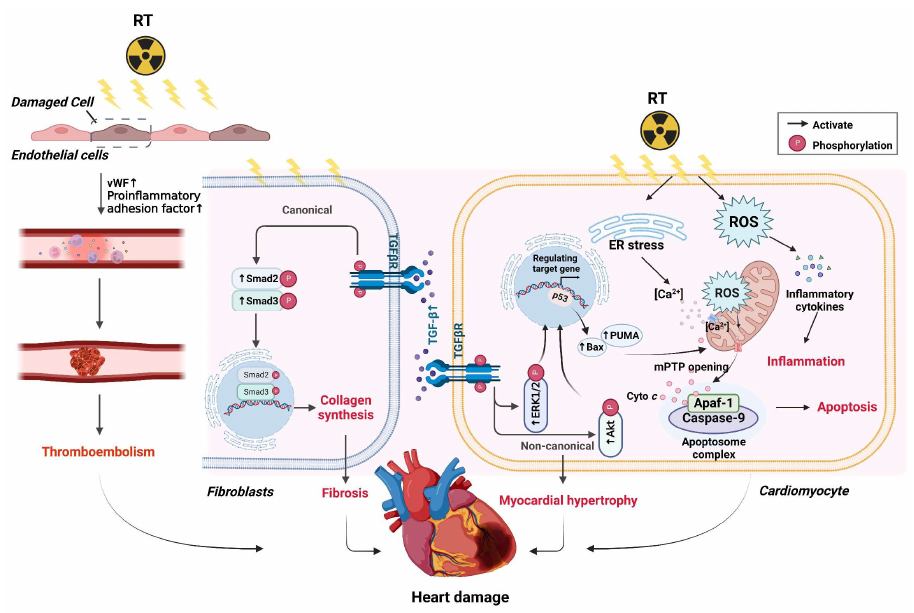
Figure 3. Mechanisms of radiotherapy-induced cardiotoxicity. Radiotherapy stimulates Ca 2+ release from the ER, causing Ca 2+ overload in mitochondria. Radiation-produced ROS leads to mitochondrial dysfunction and activation of endogenous apoptotic pathways. ROS can induce an inflammatory response. Radiation causes increased expression of TGF/ β , which induces myocardial hypertrophy by targeting ERK1/2 and AKT signaling pathways. Radiotherapy increases the risk of thrombosis by upregulating expression of vWF and proinflammatory adhesion factors, as well as causing endothelial damage. RT, radiotherapy; Bax2, bcl-2-associated X protein; Apaf-1, apoptotic protease activating factor-1; PUMA, polyunsaturated fatty acid; Cyto c, cytochrome c. Created with BioRender.com.